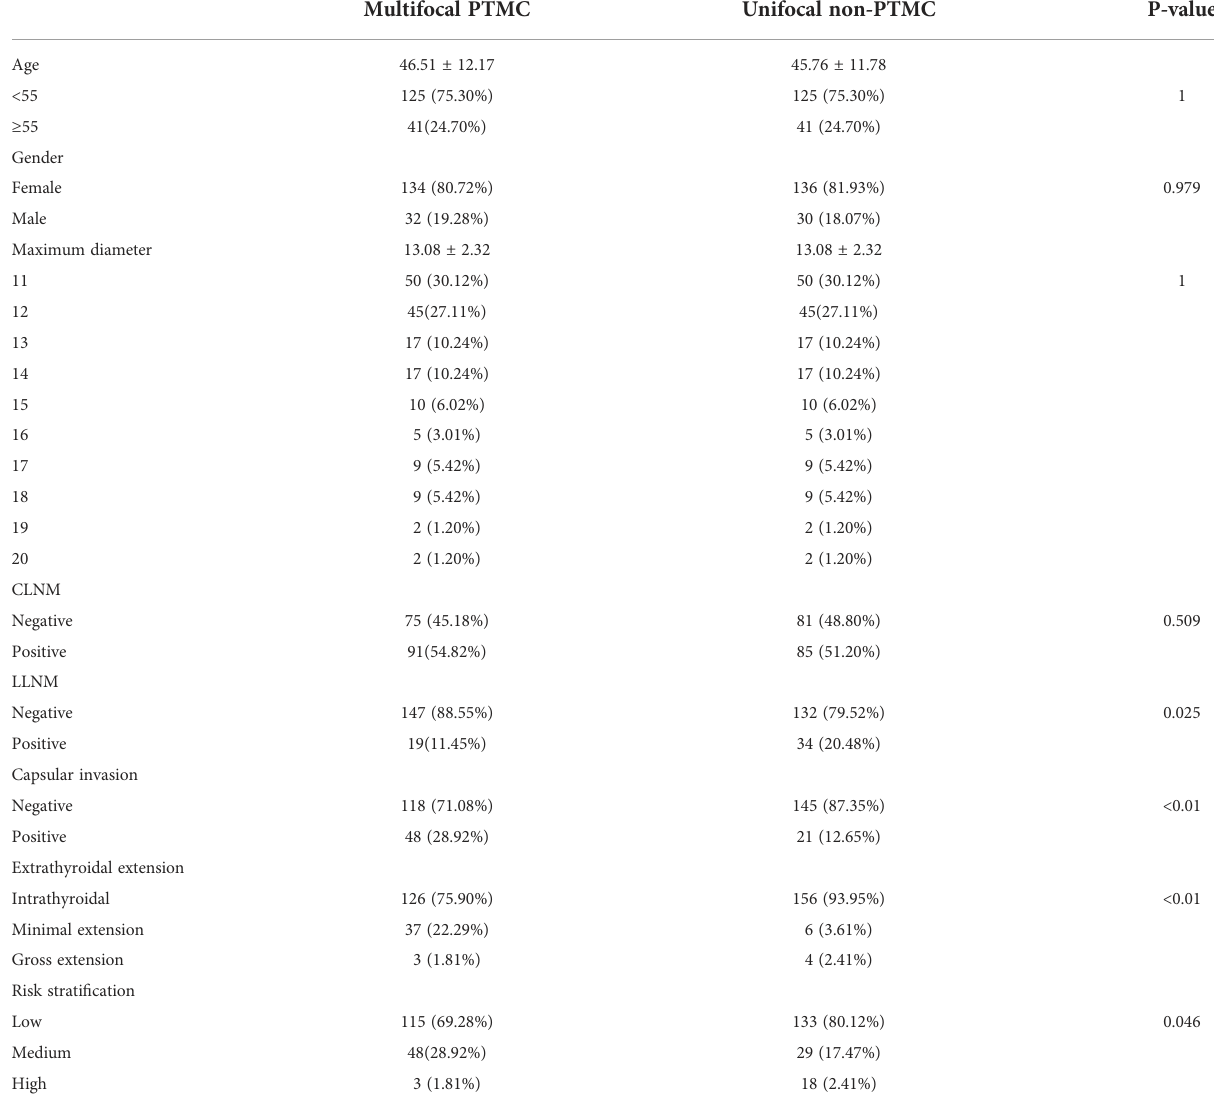
TABLE 4 Comparison of clinicopathological features between multifocal PTMC and unifocal non-PTMC after PSM.